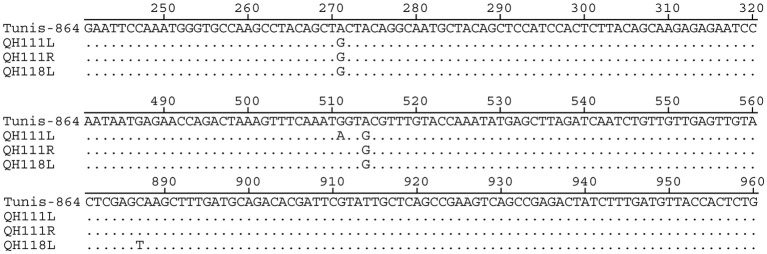
Alignment of ompAs of the B/Tunis-864, QH111L, QH111R, and QH118L strains.